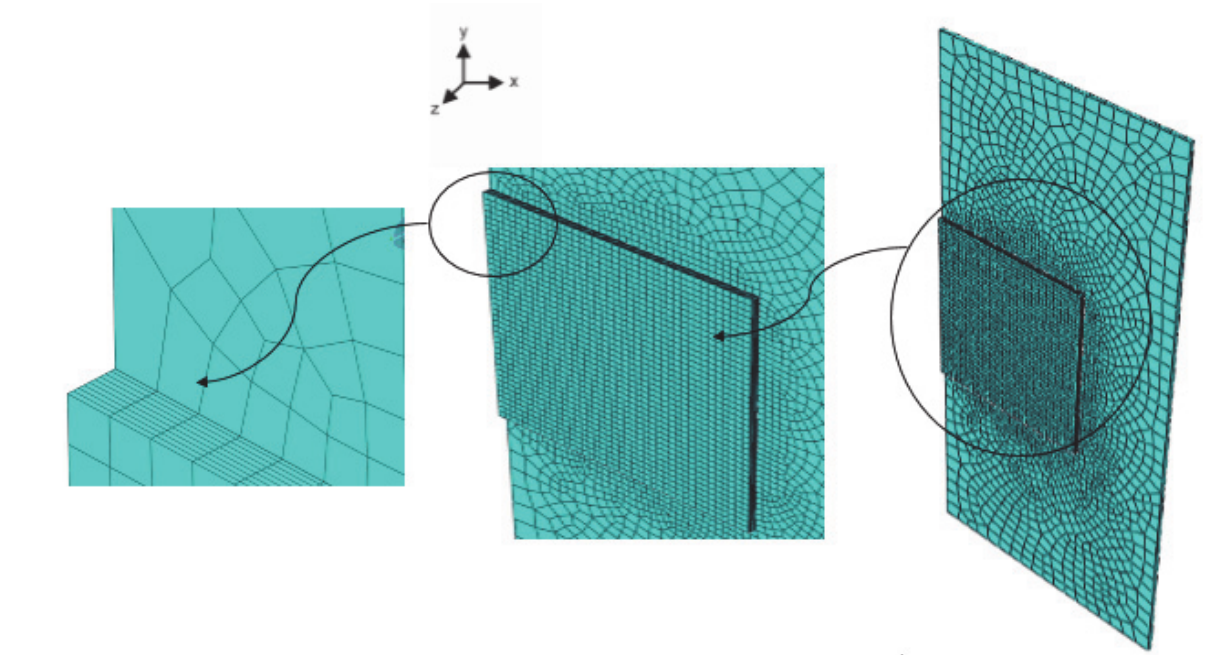
Figure 4 : Mesh details of repaired plate.